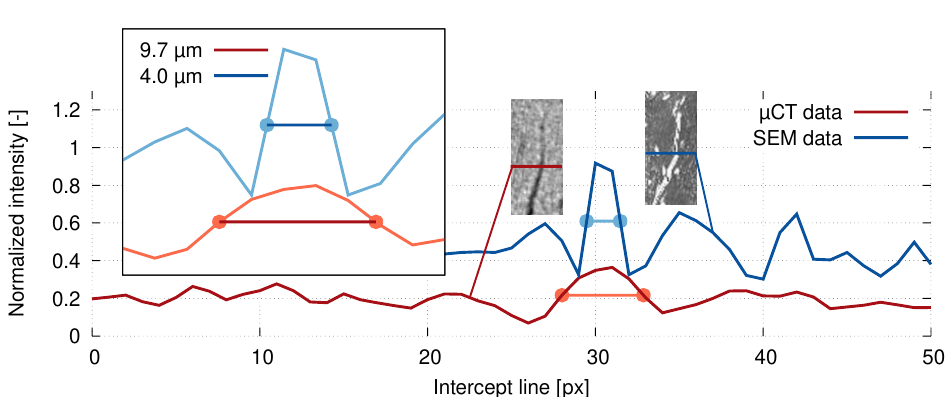
Figure 5. The crack thickness calculation based on the full-width half-maximum (FWHM) method using the line intensity profiles based on the SEM (blue) and XCT (red)